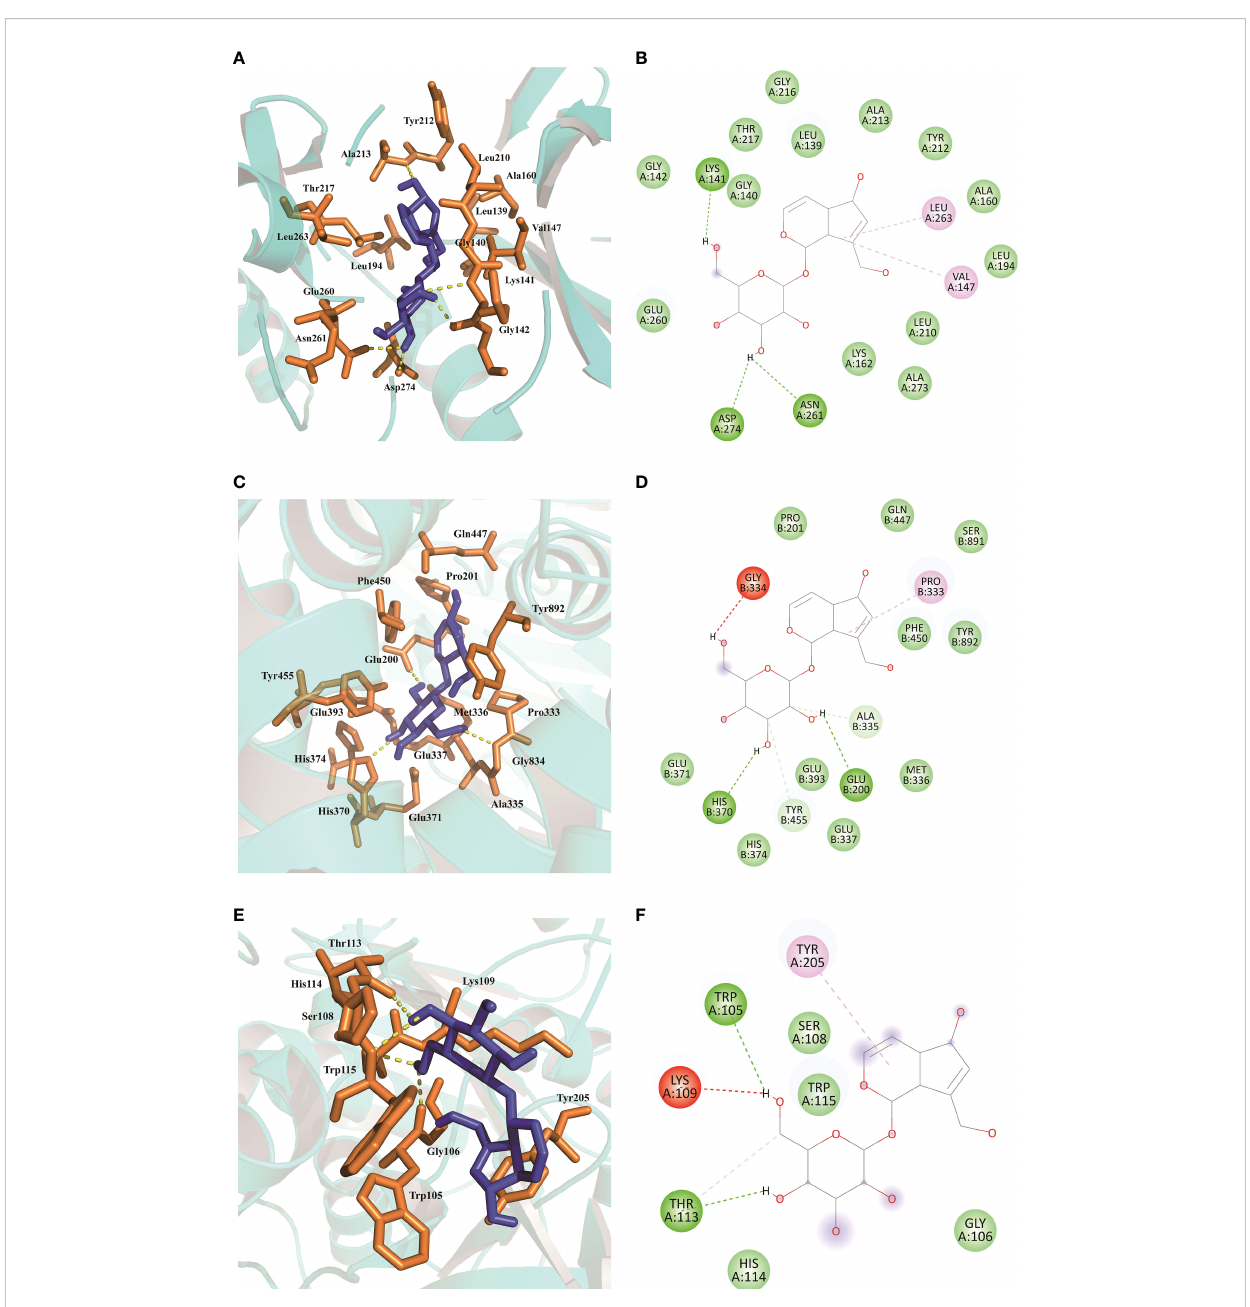
FIGURE 9 Molecular docking results of AU interaction with AURKA , ERAP2 and PLA2G7 . (A, B) Molecular docking conformation of AU interaction with AURKA . (C, D) Molecular docking conformation of AU interaction with ERAP2 . (E, F) Molecular docking conformation of AU interaction with PLA2G7